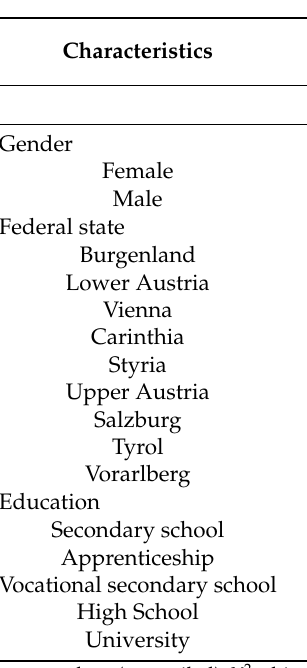
Table 1. Sociodemographic characteristics of the